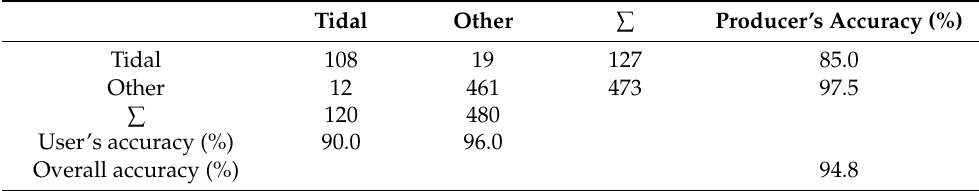
Table 3. RF method confusion matrix.